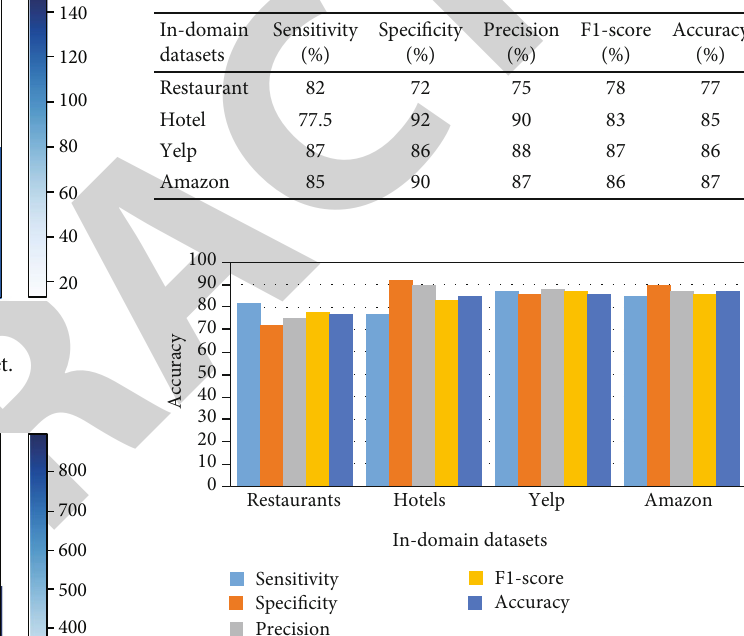
Figure 7: Confusion matrix for Amazon dataset. Table 2: Classi fi cation results for in-domain experiment.